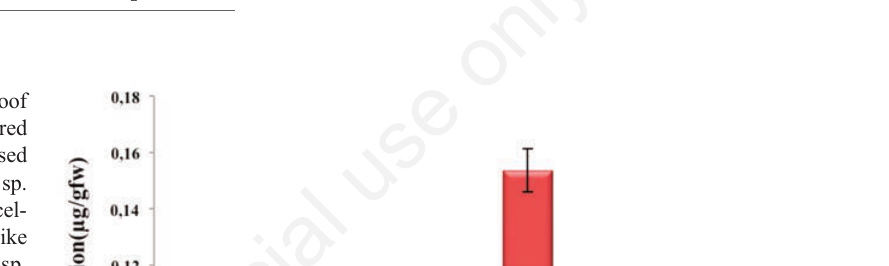
Figure 4. Absorption spectra of methanolic extracts of crust sam- ples from different historical monuments of Varanasi, India (a) Ramnagar Fort, (b) Madhavrav’s dharhara, (c) Brahaspati Temple, (d) Bharatmata Temple, (e) Sanskrit University, (f) Jalnigam’s old tank and (g) Vishwanath Temple, BHU. All the experiments were repeated thrice with at least three replicates.